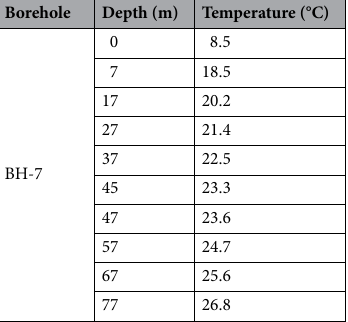
Table 5. Measured temperature in 7